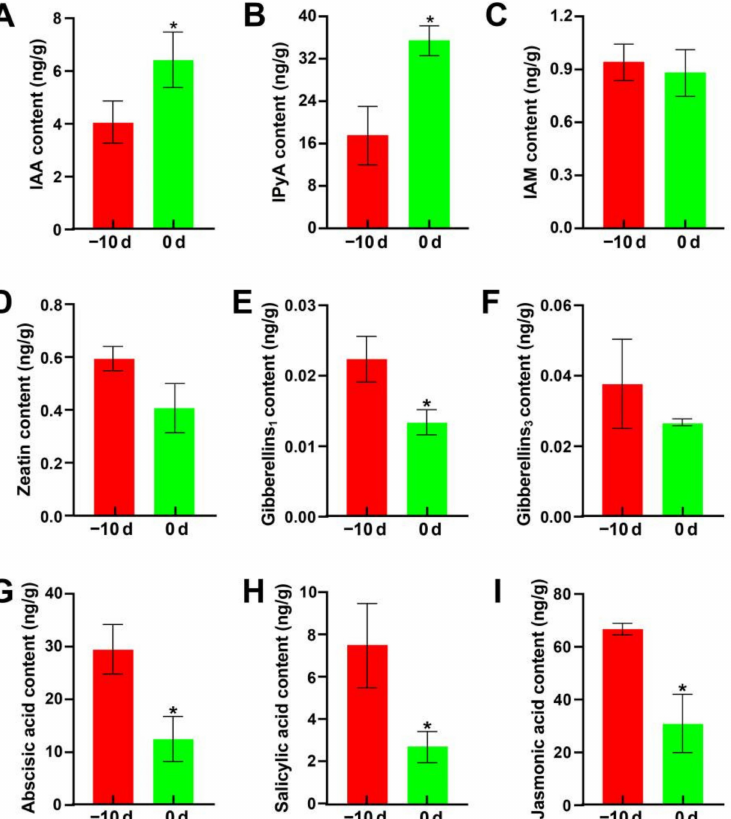
Figure 5. Hormone content at the early stage of stem-gall formation. ( A – I ) IAA, IPyA, IAM, ZT, GA 1 , GA 3 , ABA, SA and JA. Asterisks (*) indicate significant differences ( p < 0.05) between same form of hormone content in the different stage of stem-gall